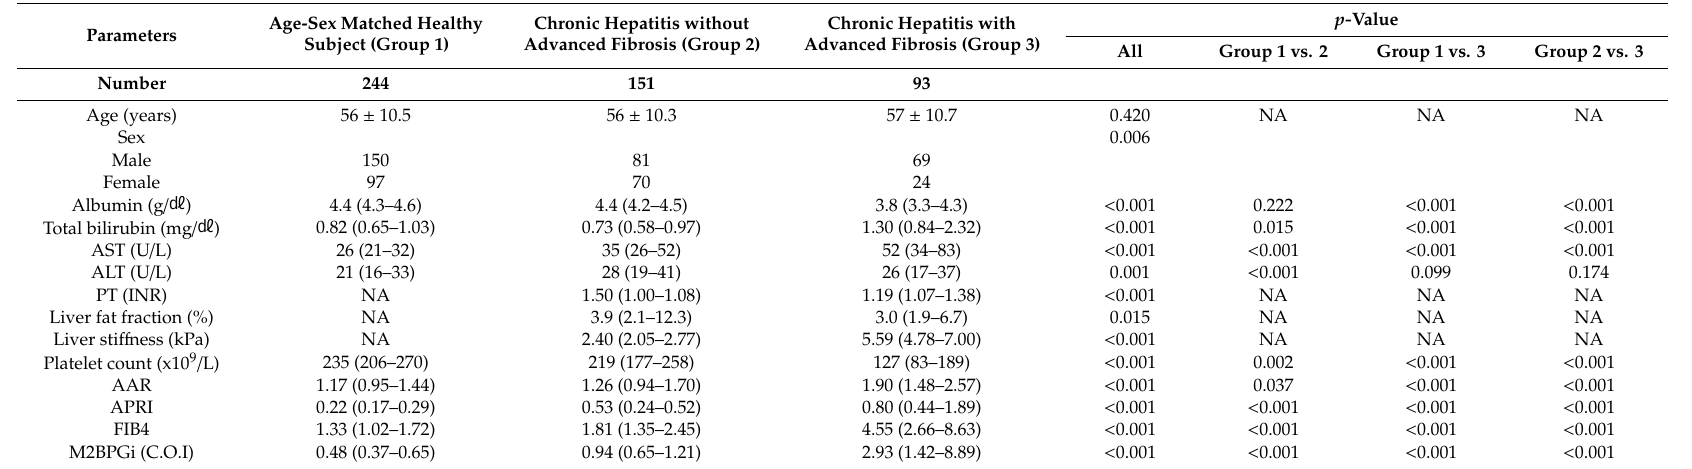
Table 1. Clinical and laboratory characteristics comparing healthy subjects (Group 1), chronic hepatitis subjects without advanced fibrosis (Group 2), and chronic hepatitis subjects with advanced fibrosis (Group 3).